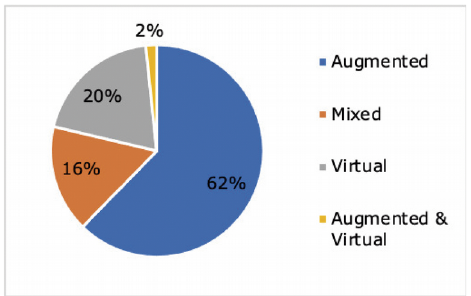
Figure 4. Type of technologies